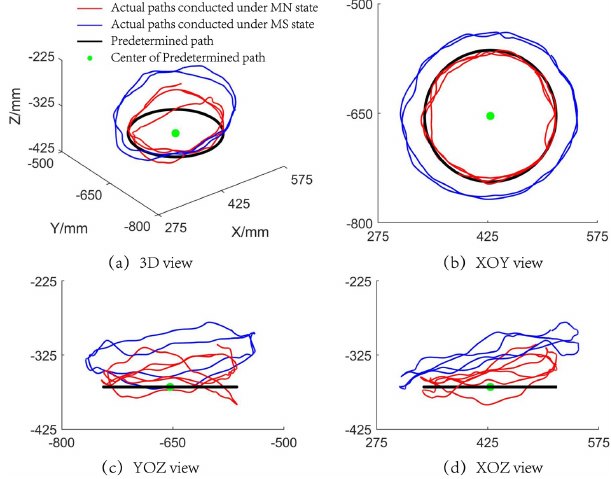
Figure 8. The actual paths traveled by the hand of subject S 1 under condition T16, showing (a) the 3D view of the paths as well as the (b) xoy , (c) yoz and (d) xoz views of the